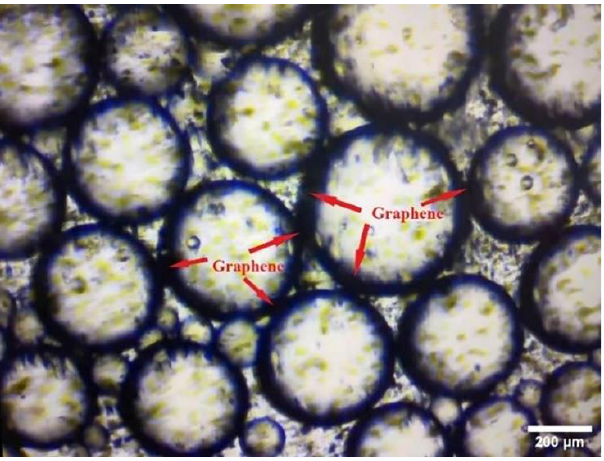
Figure 12. Microstructure of GPG foam under electron microscope.